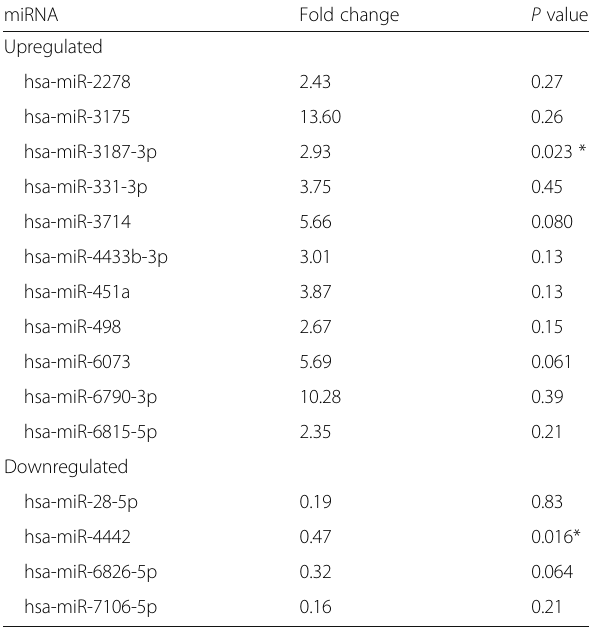
Table 3 Changes of miRNA expression in PM/DM patients after treatment